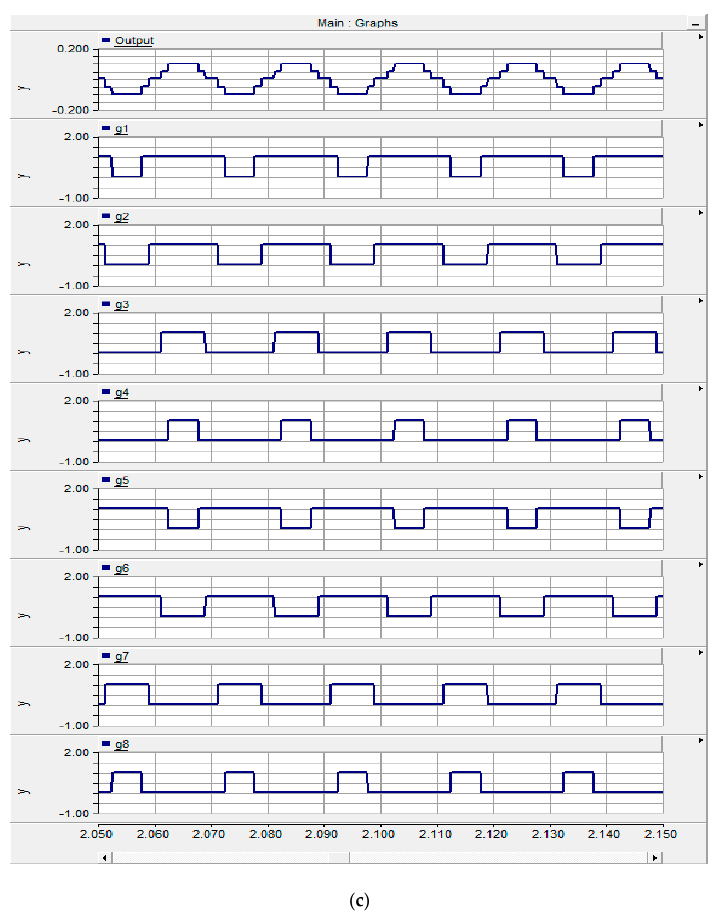
Figure 11. ( a ) Power circuit of 5-level FC-MLI; ( b ) control circuit of 5-level FC-MLI; ( c ) phase output voltage waveform of 5-level FC-MLI. Table 6. Voltage levels of 5-level FC-MLI and switching states.